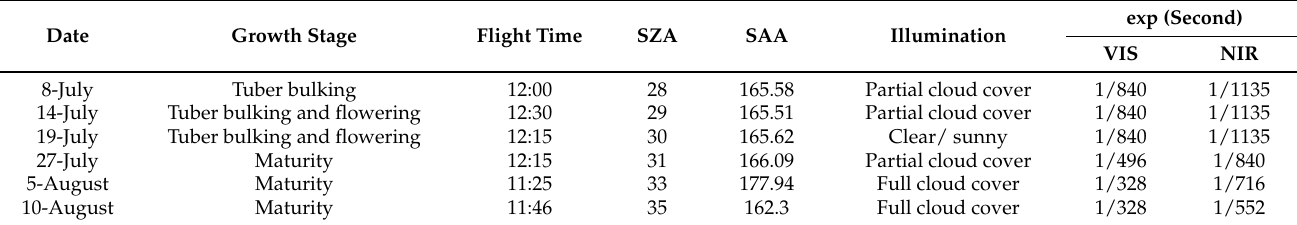
Table 1. Flight conditions and camera settings for the campaigns in